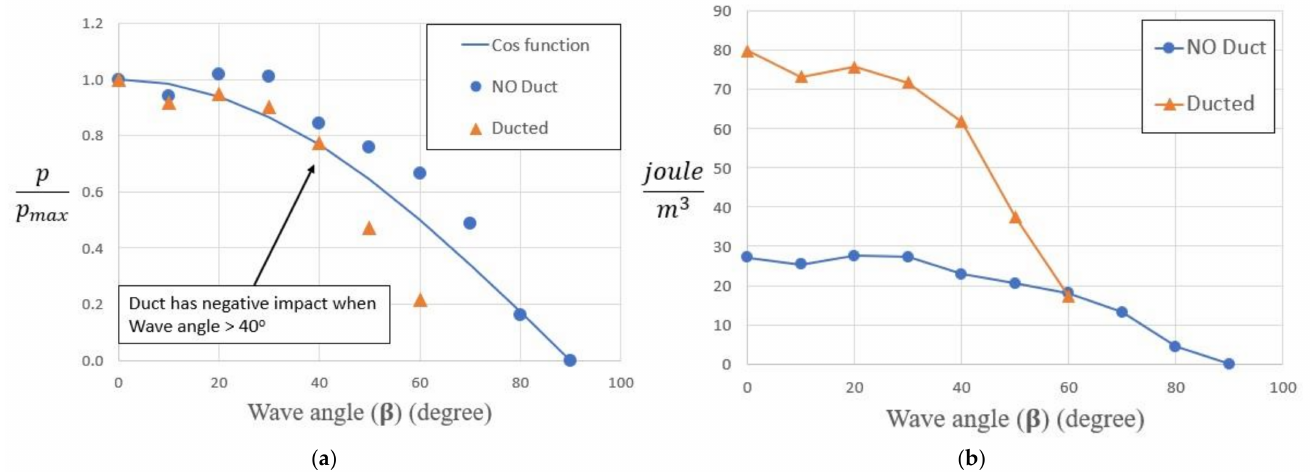
Figure 18. ( a ) The normalized pressure measurement for the no duct case (blue circle) and ducted case (orange triangle) at various wave angles ( β ). A theoretical cosine line (blue line) is added as a guidance; ( b ) the energy per m 3 of water measurements for the no duct case (blue circle) and the ducted case (orange triangle) at various wave angles ( β